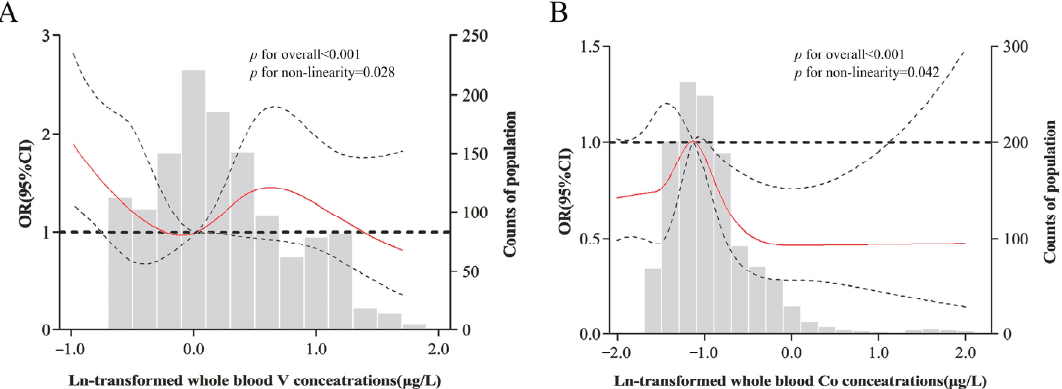
Figure 2. The RCS with five knots for the association between blood metal levels and incident females’ hyperuricemia. The red lines indicate adjusted odds ratios and dotted lines are the 95% confidence intervals based on the restricted cubic spline models for the natural log-transformed concentrations of whole blood V ( A ) and Co ( B ) in females. The reference values were set at the 10th percentiles. Adjusted variables are the same as those listed for the single-metal model.